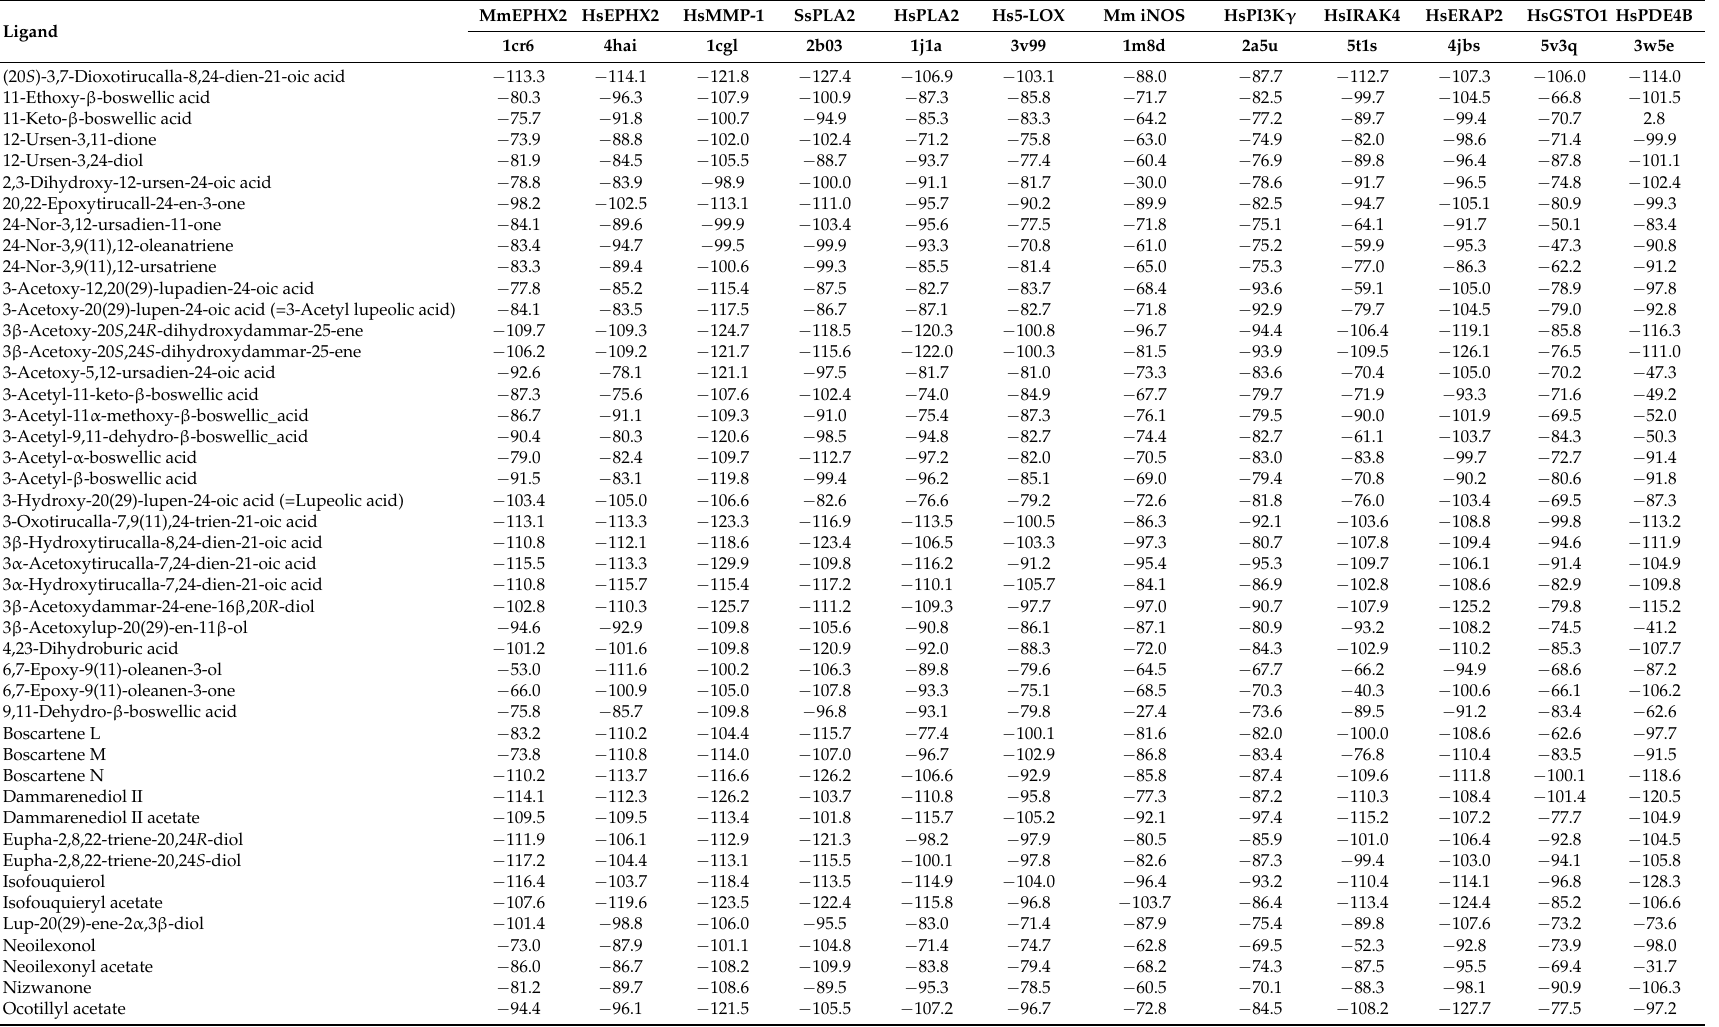
Table 7. MolDock docking energies (kJ/mol) of Boswellia triterpenoid ligands with inflammation-relevant protein